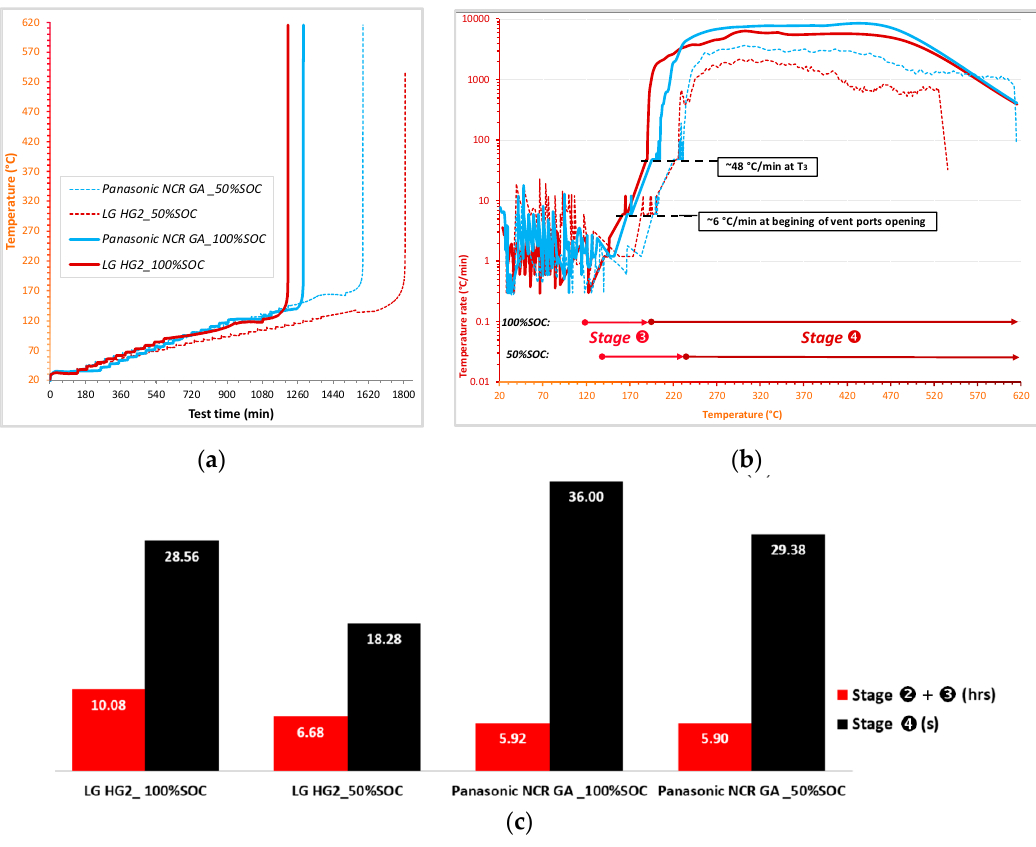
Figure 14. ( a ) Temperature profiles versus test time and ( b ) temperature rate versus temperature of the 50% and 100% SOC LG HG2 and Panasonic NCR GA cells. ( c ) Duration of the reversible self-heating region (stage + ) and duration of the irreversible self-heating region (stage ) during thermal runaway of the presented cells.